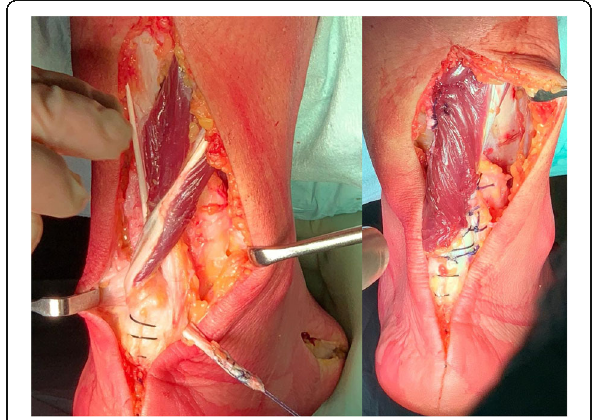
Fig. 5 Surgical technique images. At left, peroneus brevis tendon crossing the calcaneal tunnel from medial to lateral (note the harvesting site on the lateral aspect of the base of the fifth metatarsal); at right, the final result of the